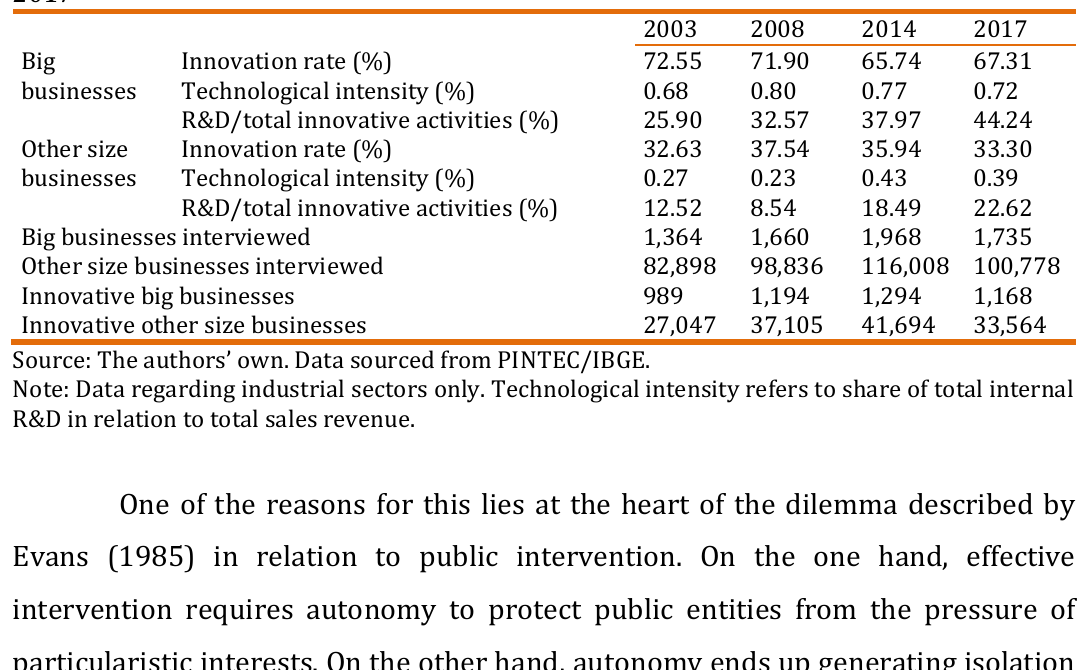
Table 04 . BB versus other size business, innovation indicators, industrial sector, 2003